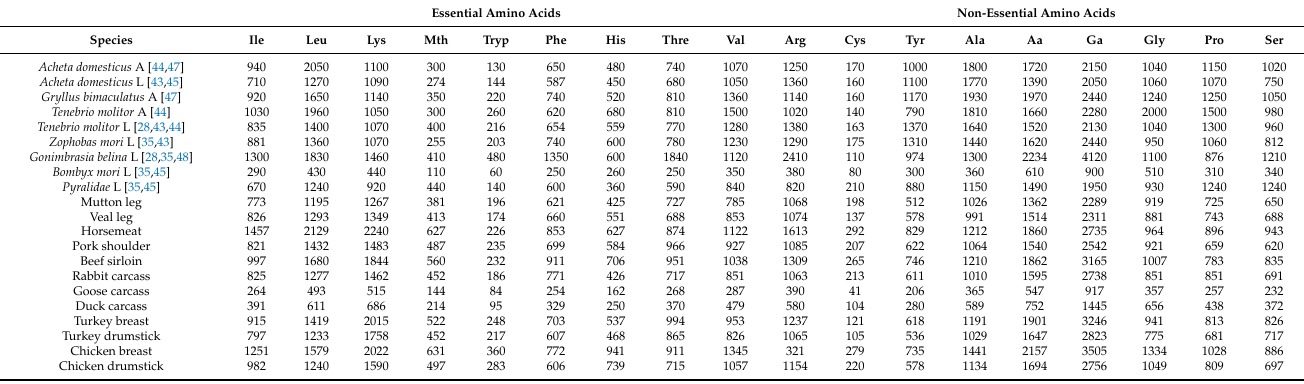
Table 3. Amino acid composition data of edible insects and meat (mg/100 g edible portion) [28,35,43–45,47,48].